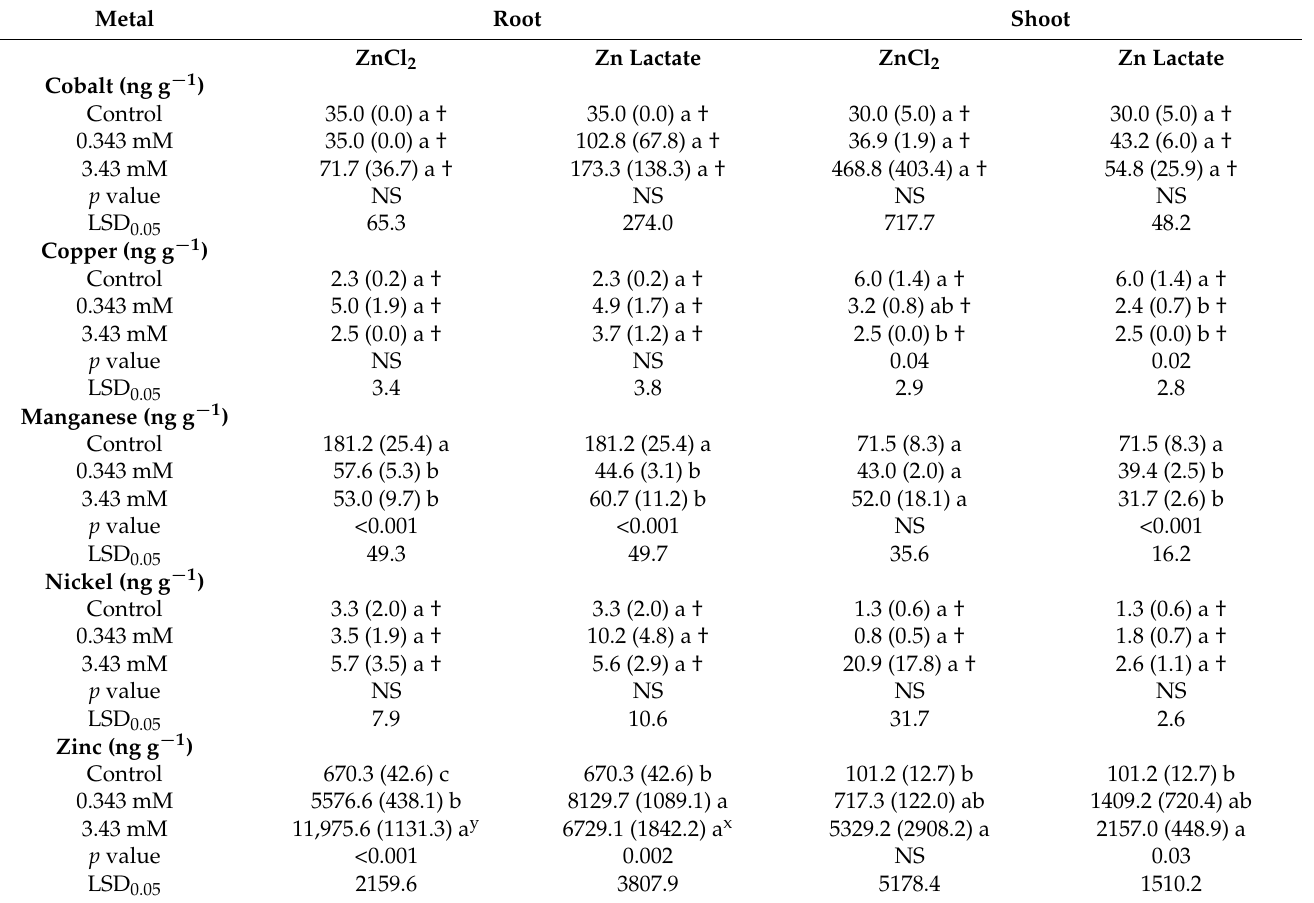
Table 2. Mean concentration of Co, Cu, Mn, Ni and Zn in the root and shoot tissues of wheat grown with zinc chloride or zinc lactate. Control samples did not receive any zinc supplementation. Different letters indicate a statistically significant difference between treatment concentrations and control ( p < 0.05; Fisher’s LSD Test). The “†” symbol indicates that the mean was derived from one or more replicates with metal concentrations below the instrument detection limit (DL) and were substituted with values equal to the DL/2. Superscripts “x” and “y” denote a significant difference between zinc chloride and zinc lactate ( p < 0.05; simple t -test). Standard error is denoted in parenthesis; n = 5. NS: not